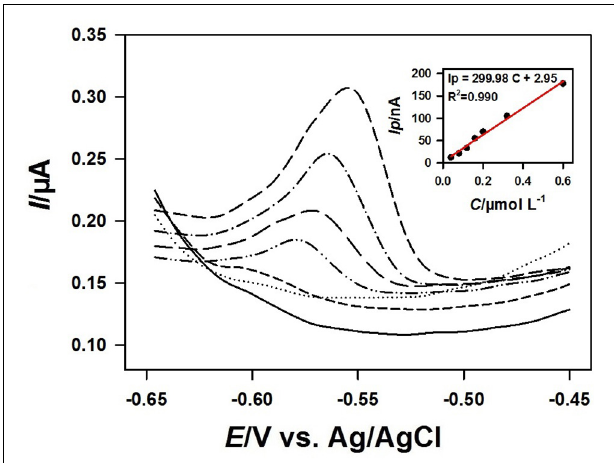
FIGURE 8 | Square wave voltammograms obtained at the 3DrGO/F-BiNSs/ANE with successive addition of 0.04, 0.08, 0.12, 0.16, 0.20, 0.32, 0.60 µ mol L − 1 Pb 2 + in 0.1 mol L − 1 acetate buffer (pH 3.5). Inset shows the corresponding calibration curve of Pb 2 + from 0.04 to 0.60 µ mol L − 1 ( n = 3) at the 3DrGO/F-BiNSs/ANE.